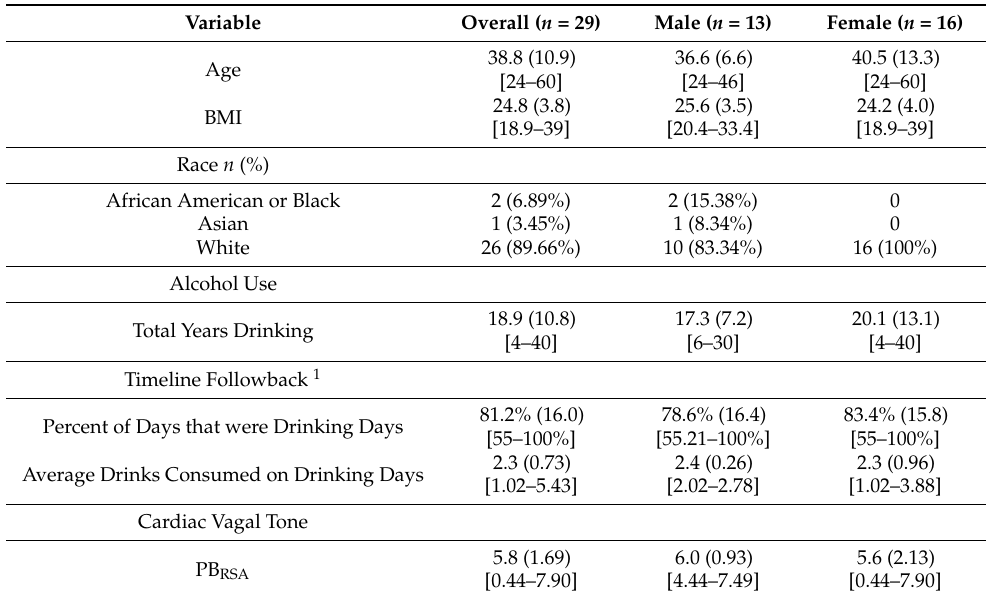
Table 1. Sample demographics. Listed as Mean (Standard Deviation) or Frequency (Percentage), [range]. There were no significant differences between males and females in any variable.